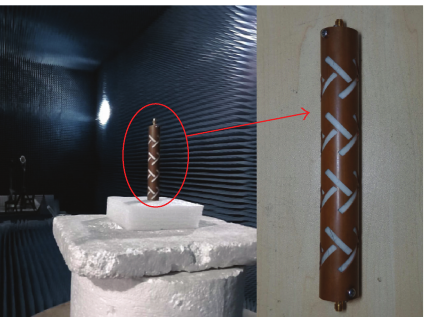
Figure 3: Photograph of the omnidirectional CP antenna being tested in the anechoic chamber.